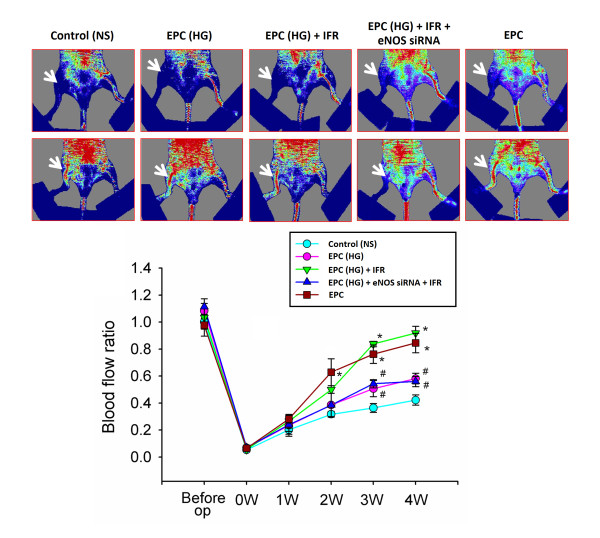
 IFR treated-EPC transplantation improved blood perfusion in the ischemic hindlimb. (A) Representative images of hindlimb blood flow measured by laser Doppler and quantitative analysis of blood flow expressed as perfusion ratio of the ischemic to the contralateral (non-operated) hindlimb immediately after hindlimb ischemia surgery and 3 weeks after intramuscular injection of normal saline, EPC-treated with high glucose (EPC-HG), EPC-treated with high glucose and FIR therapy (EPC-HG + IFR), or EPC treated with high glucose and IFR and eNOS siRNA (EPC-HG + eNOS siRNA + IFR). (*p < 0.05 compared with control; #p < 0.05 compared with EPC-HG + IFR; n = 6).